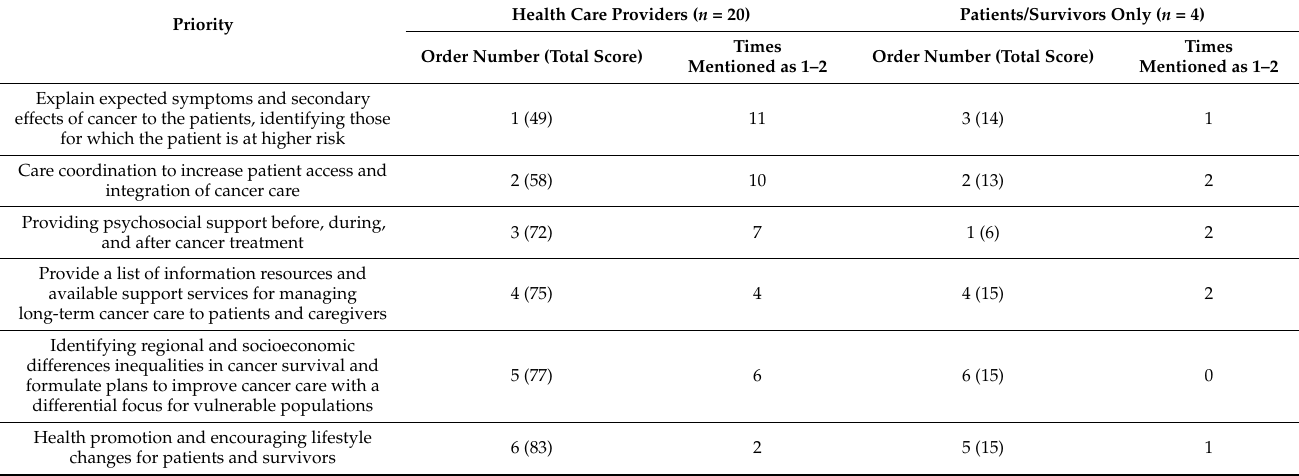
Table 1. Priorities of healthcare professionals and patients/survivors in